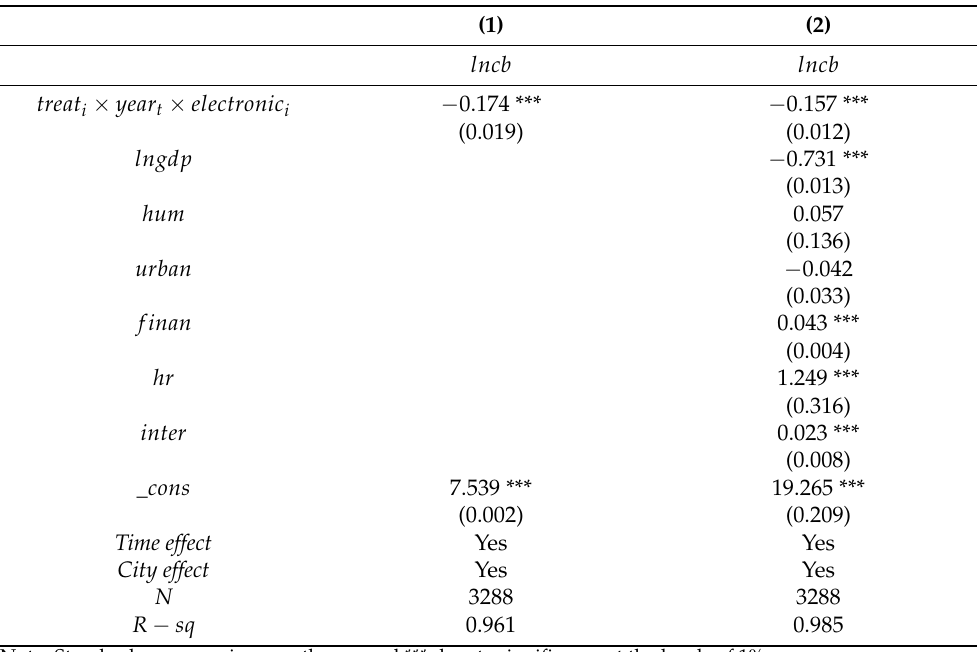
Table 9. The interactive effect of